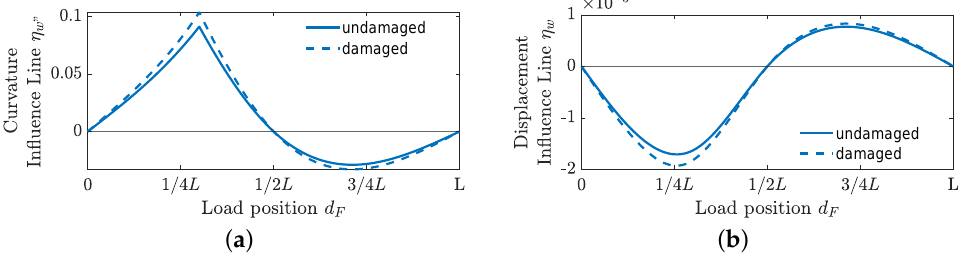
Figure 2. Example influence lines with reference point x ref = 3 bending beam. Change in bending stiffness is at ∆ EI = 20% between b 1 = 2 ( a ) Curvature influence line at x ref = 3